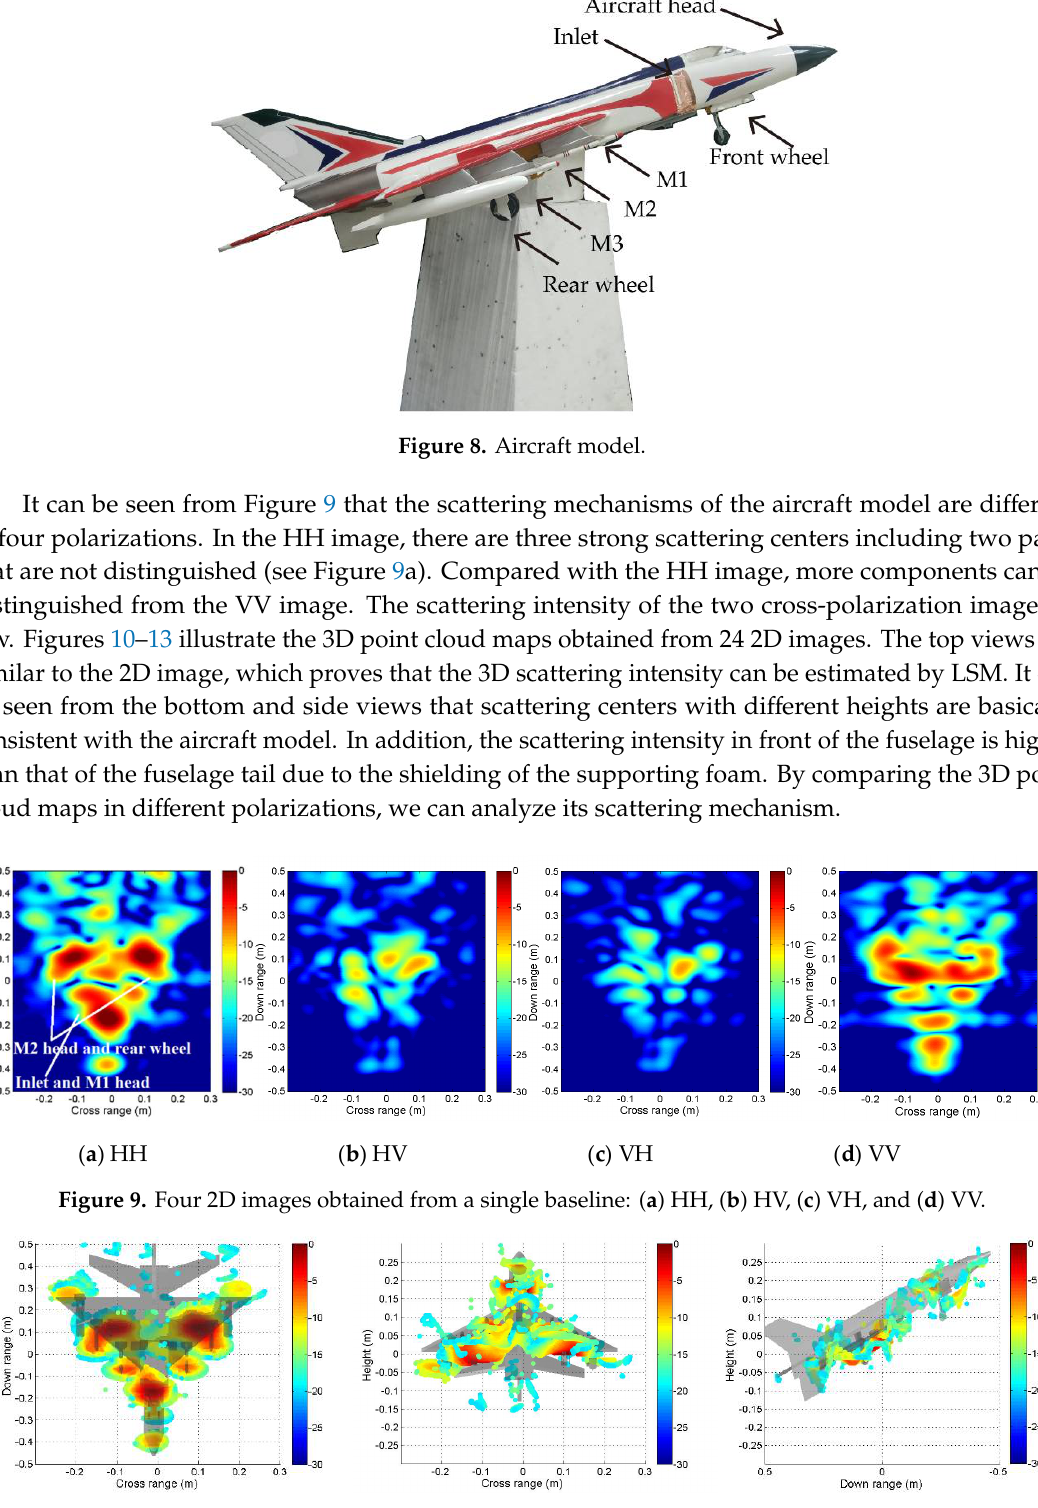
Figure 7. An experimental polarimetric MIMO array.